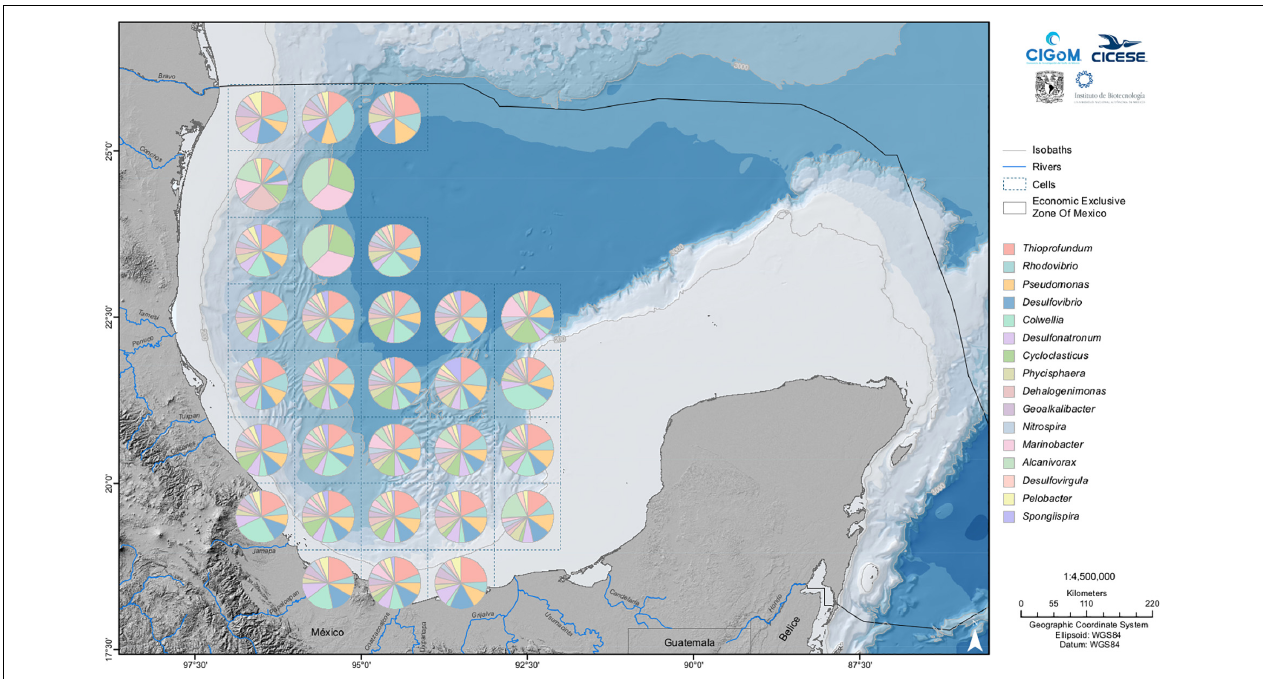
FIGURE 4 | Sixteen most abundant genera in the superficial sediments of the Gulf of Mexico. The map covers a rectangular area with the bottom right corner at 18 ◦ N, 86 ◦ W to top left corner at 97 ◦ W, 26 ◦ N. The superficial sediments range from 12 to 3741